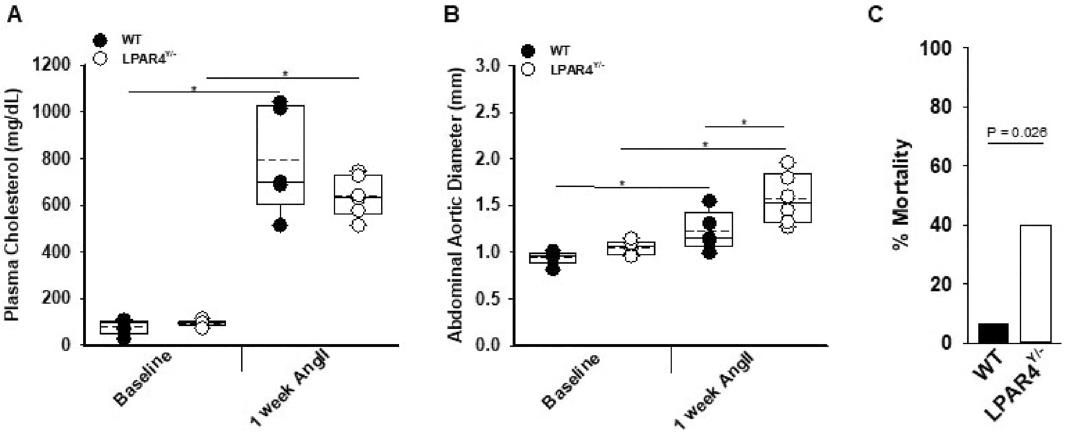
Figure 6. Loss of lysophosphatidic acid receptor 4 increases abdominal aortic aneurysm formation. ( A ) Plasma cholesterol at baseline and post-1 week AngII were measured in WT (n = 5) and LPAR4 Y/− (n = 6) mice, * P < 0.001 Two way ANOVA, Bonferroni t-test, all pairwise multiple comparison. ( B ) Abdominal aortic diameter measurements of WT (n = 5) and LPAR4 Y/− (n = 6) were measured using ultrasound at baseline and 1 week AngII. * P < 0.05, Two way ANOVA, Holm-Sidak, all pairwise multiple comparison. ( C ) Percent mortality of WT (n = 16) and LPAR4 Y/− (n = 20) mice within one week of treatment with AngII; P = 0.026 by Fisher’s exact